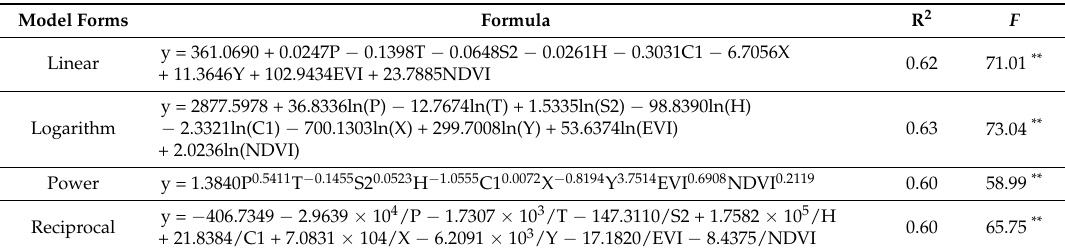
Table 7. Best fitted models constructed based on multiple